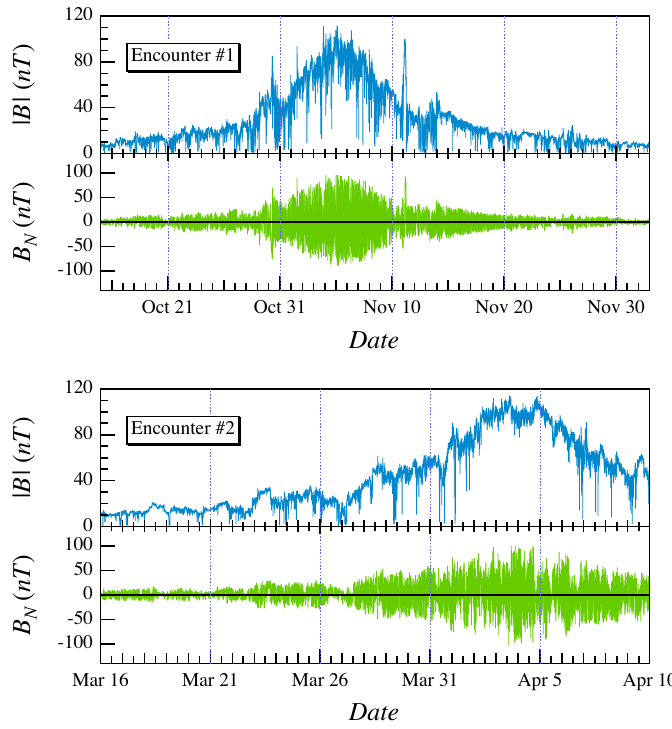
Figure 1. The magnetic field intensity ( | B | ) and the normal component ( B N ) for the two selected time intervals relative to the first (upper plots) and second (lower plots),